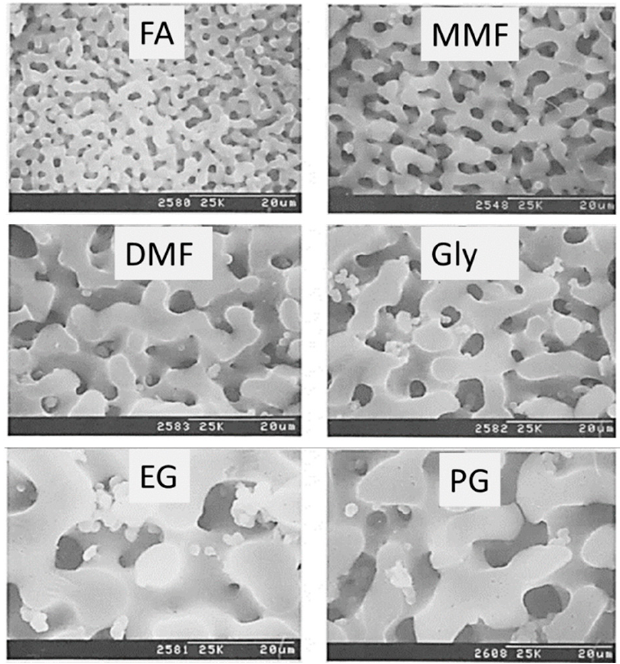
Figure 5. Effect on the gel morphologies with the type of organic solvent for the system TEOS– HPAA (of Mw 250,000) and reaction temperature 80 °C. Scale bar = 20 µm. Solubility parameters, δ s ((cal cm − 3 ) 1/2 ): formamide (FA)—19.2, N-methylformamide (NMF)—16.1, N,N-dimethylformamide